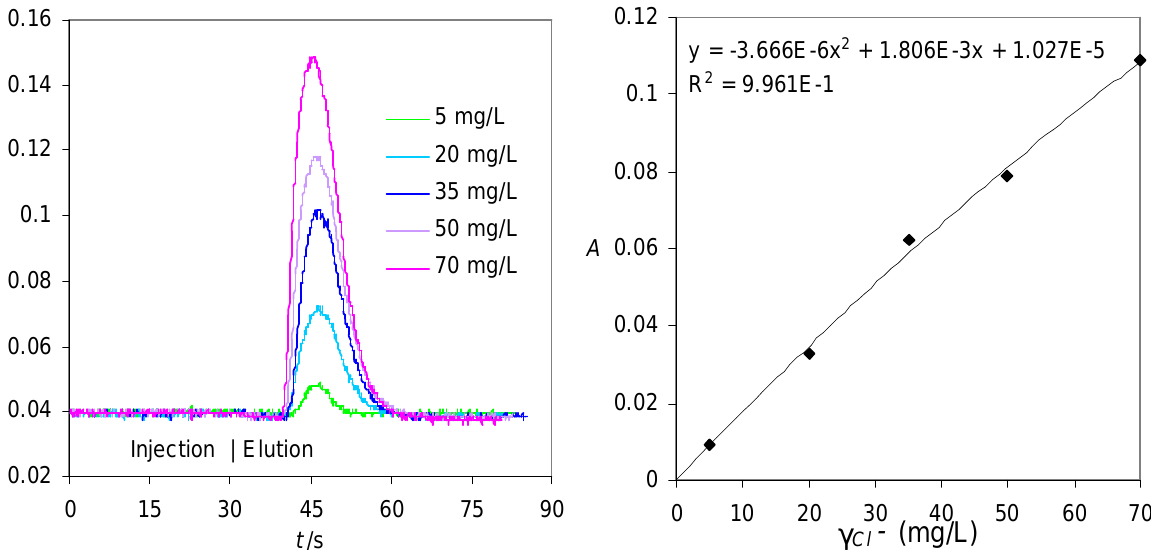
Figure 9. FIAgrams (left) and calibration line (right) obtained for calibration solutions with chloride concentration extending from 5 to 70